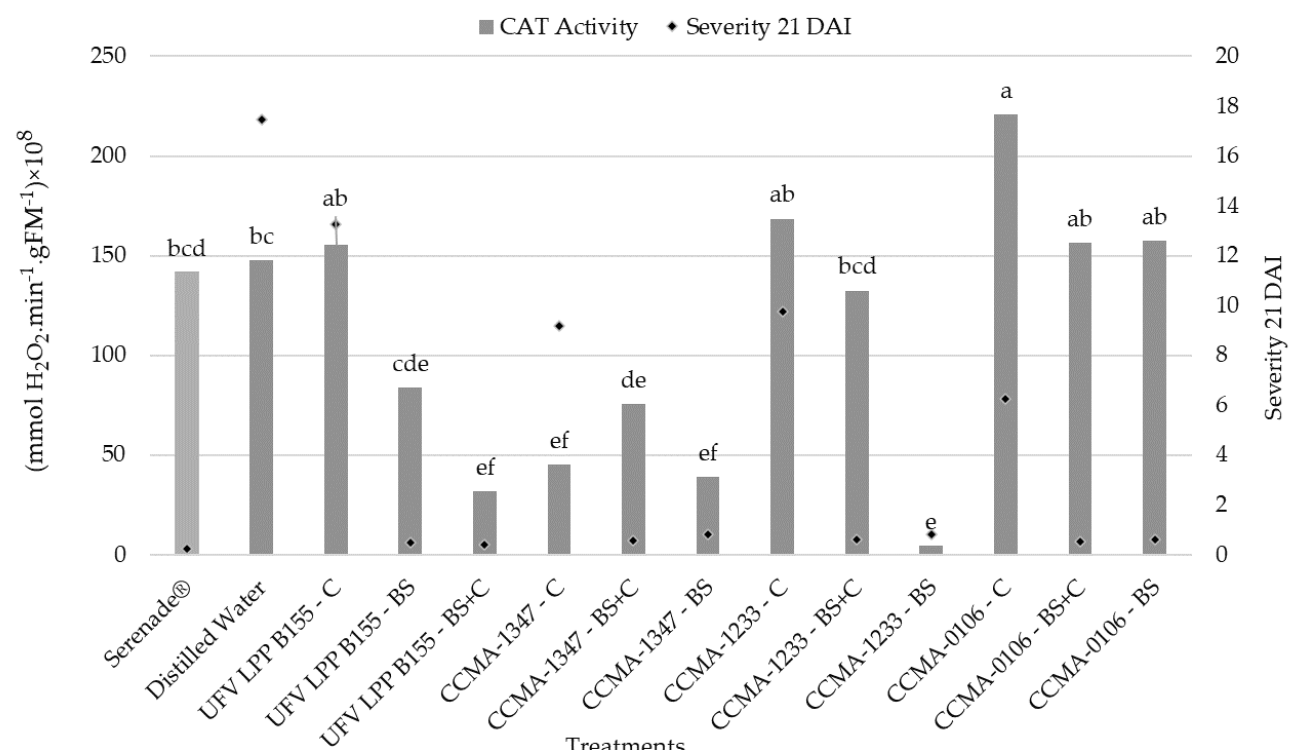
Figure 7. CAT activity 21 days after pathogen inoculation. UFV LPP B155 and CCMA-1347 = B. subtilis ; CCMA-1233 = B. licheniformis ; CCMA-0106 = P. aeruginosa . BS: Biosurfactants; C: Bacterial cells; BS + C: Biosurfactants + Bacterial cells. Bars followed by the same letter do not differ from each other by Tukey’s test α = 0.05. The primary Y-axis shows activity in mmol H 2 O 2 · min − 1 · gFM − 1 , and the secondary Y-axis shows severity, represented by the dark-colored dot. Different letters reveal statistically significant variations ( p <